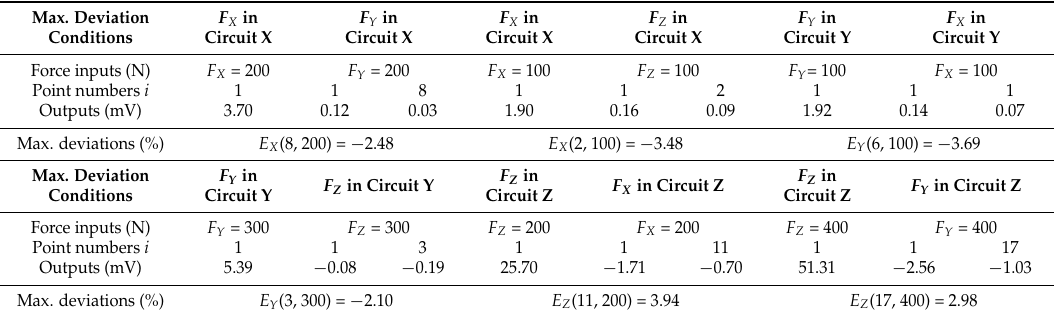
Table 3. Maximal deviations of cross couplings in different positions.